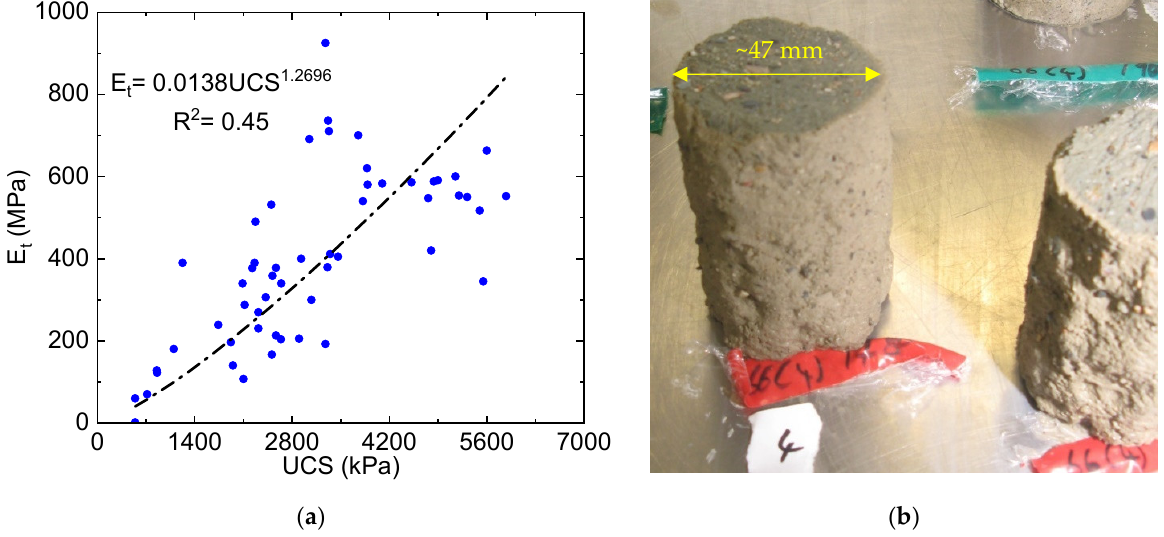
Figure 8. ( a ) Relationship between E t and UCS for Kidd, and ( b ) example of NQ diamond drill core from field tests.